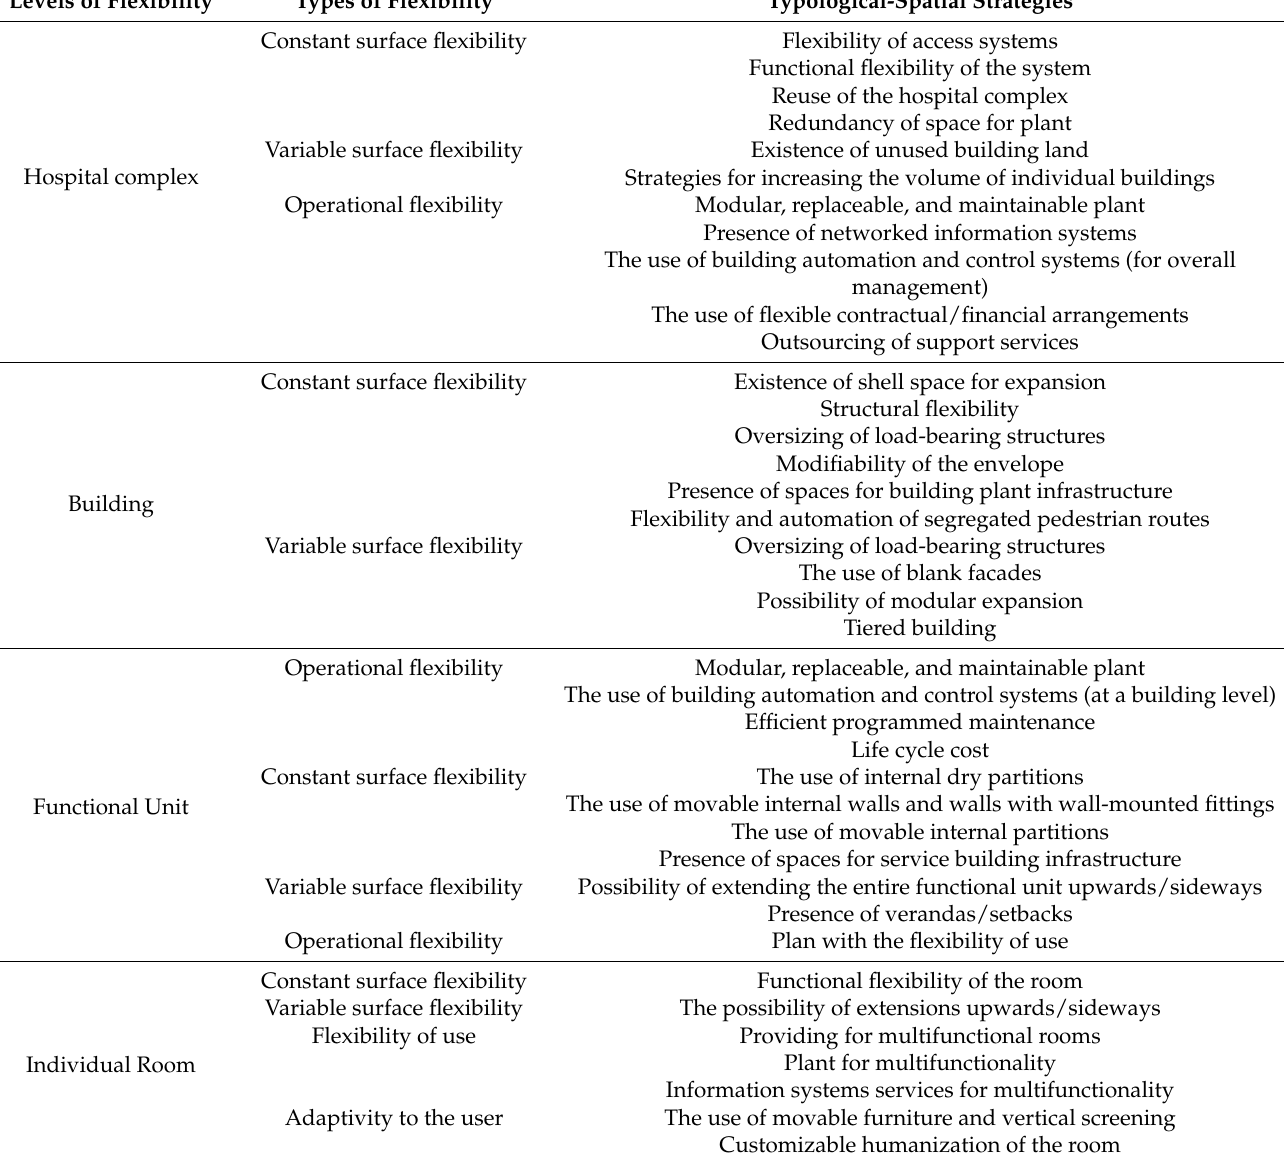
Table 5. Flexibility matrix for healthcare facilities